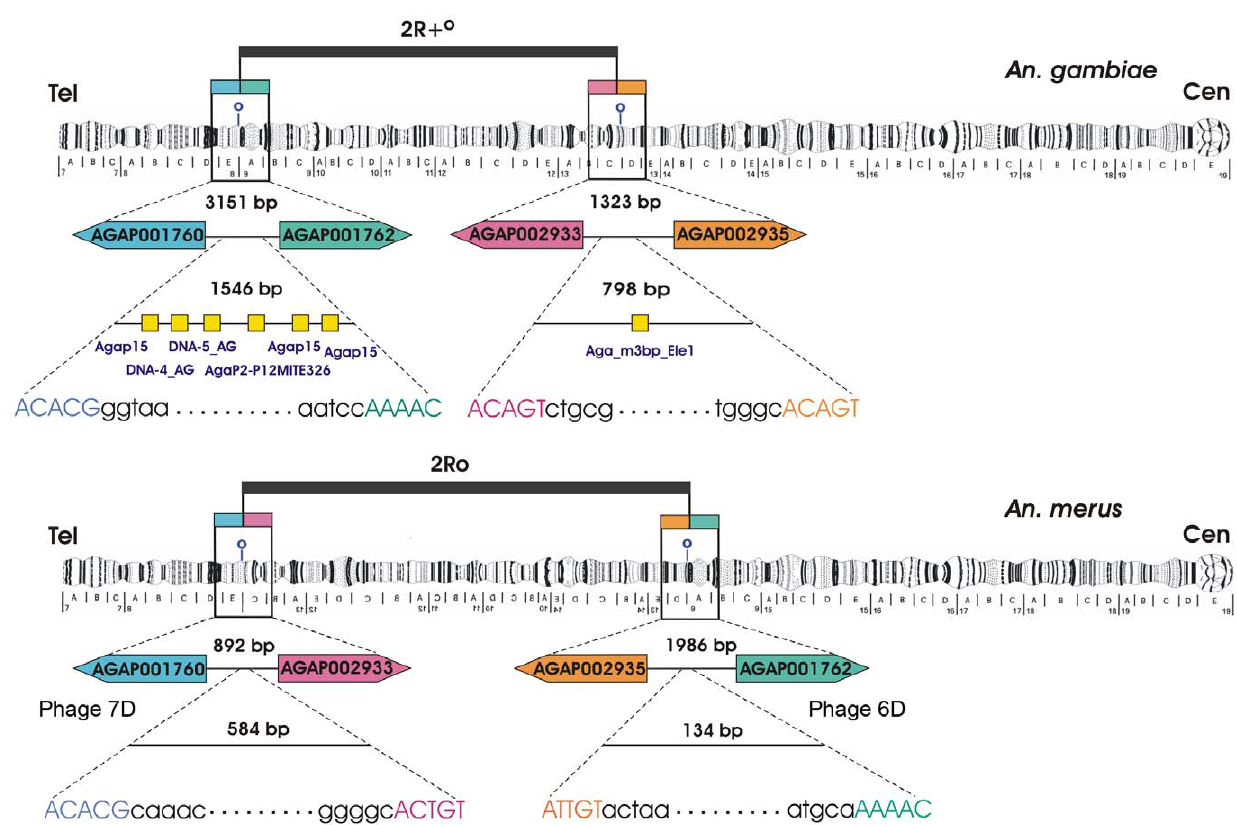
Figure 4. Structure of the 2R + o and 2Ro inversion breakpoint sequences in An.gambiae and An.merus . Distal and proximal breakpoints are shown on polytene chromosomes and in the An. gambiae genome assembly. Breakpoint sequences are shown with small letters, and their sizes are indicated in base pairs. Genes at the breakpoints are shown in their 5 9 -3 9 orientation with boxes of similar colors. Distances between the genes are shown above the intergenic regions. Homologous sequences are represented by identically colored capital letters. Yellow boxes show assemblies of degenerate TEs in An. gambiae . The sizes of genes and intergenic regions are not drawn to scale. Cen, centromere. Tel, telomere.